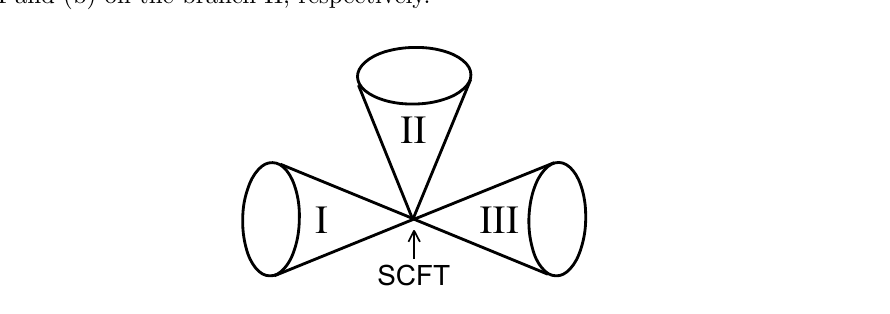
Figure 20 . Brane setups with full D1 and 1 the branch I and (b) on the branch II, respectively.